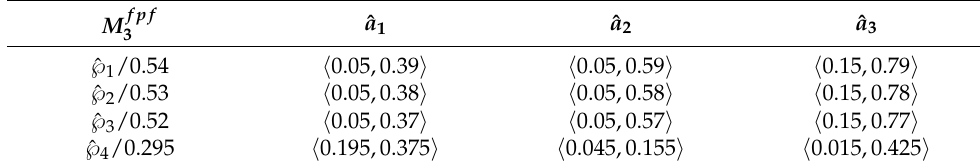
with entries in terms of CFNs. 3